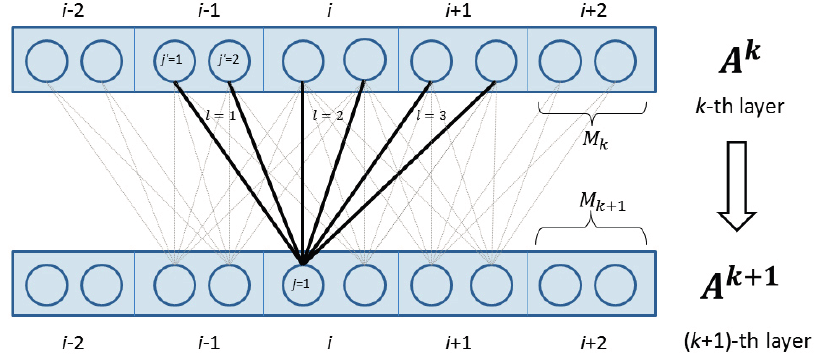
Figure 2. The feed-forward connection between two adjacent layers in the deep convolutional neural